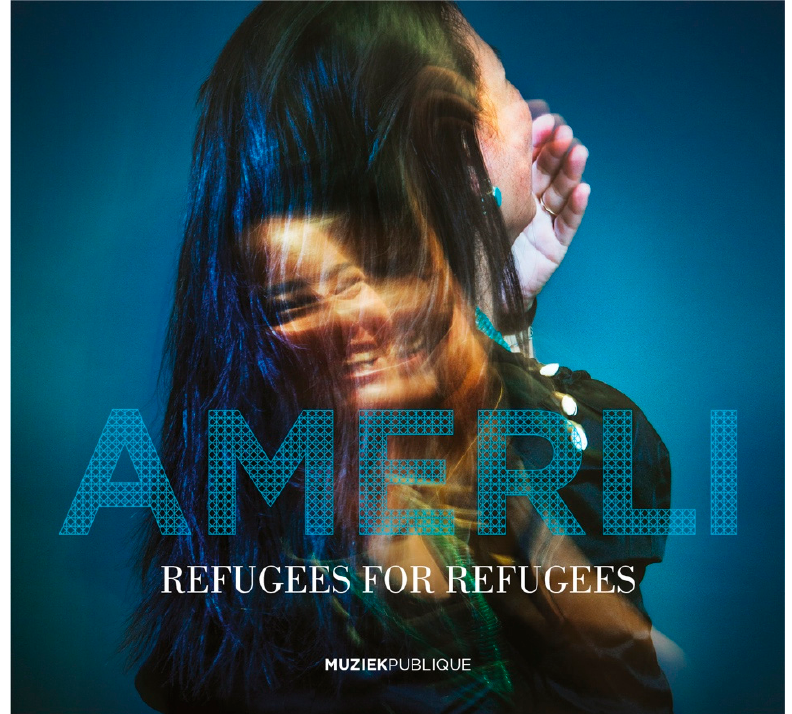
Figure 2. The cover of the album shows the Tibetan singer Dolma Renqingi. Amerli , the title of the CD, refers to an Iraqi city. Credits: Dieter Telemans, Desiree de Winter & Muziekpublique (used by permission).